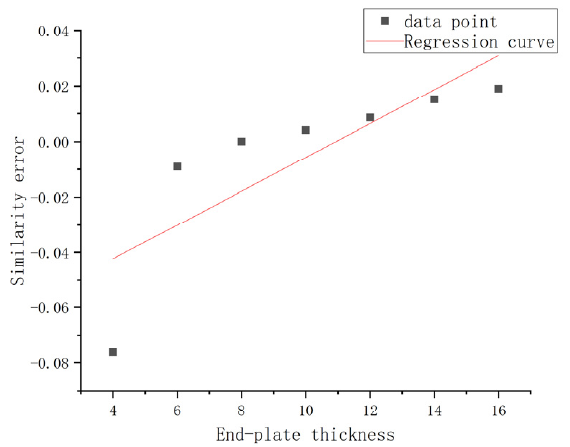
Figure 28. Data points and the regression curve at C w .